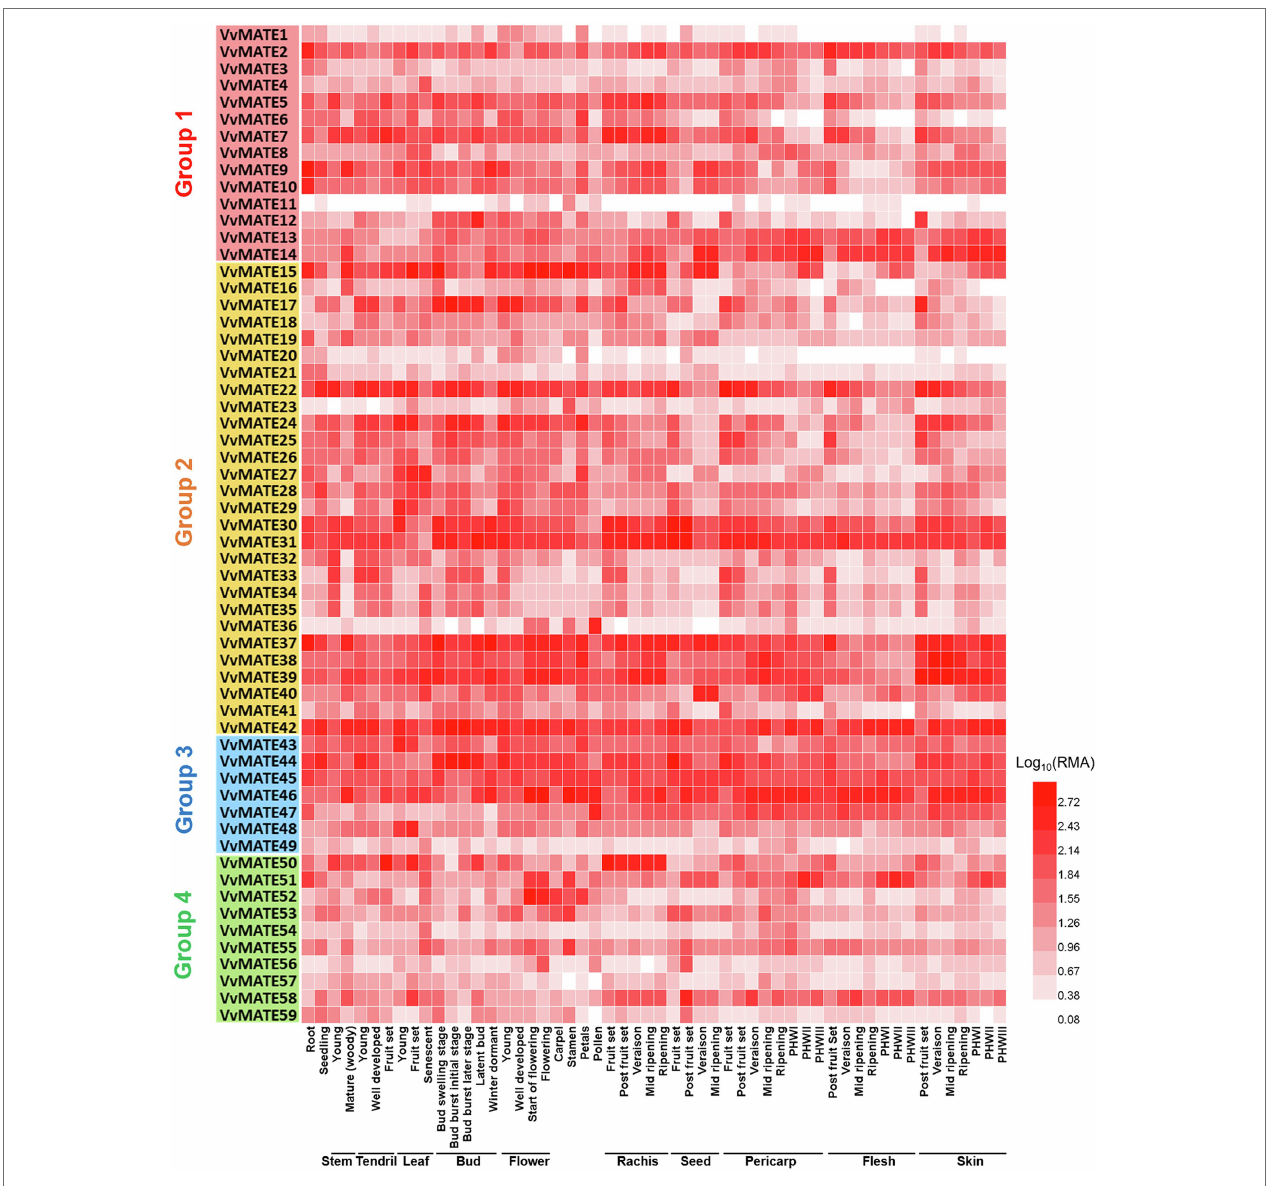
FIGURE 3 | Gene expression profiles of the grape MATEs in various organs, tissues, and developmental stages. The gene expression data of Vitis vinfera “Corvina” (GEO Accession: GSE36128) were normalized using logarithm with the base of 10. The heat maps were created by HemI (Deng et al., 2014). PHWI: post-harvest withering I, PHWII: post-harvest withering II, PHWIII: berry flesh post-harvest withering